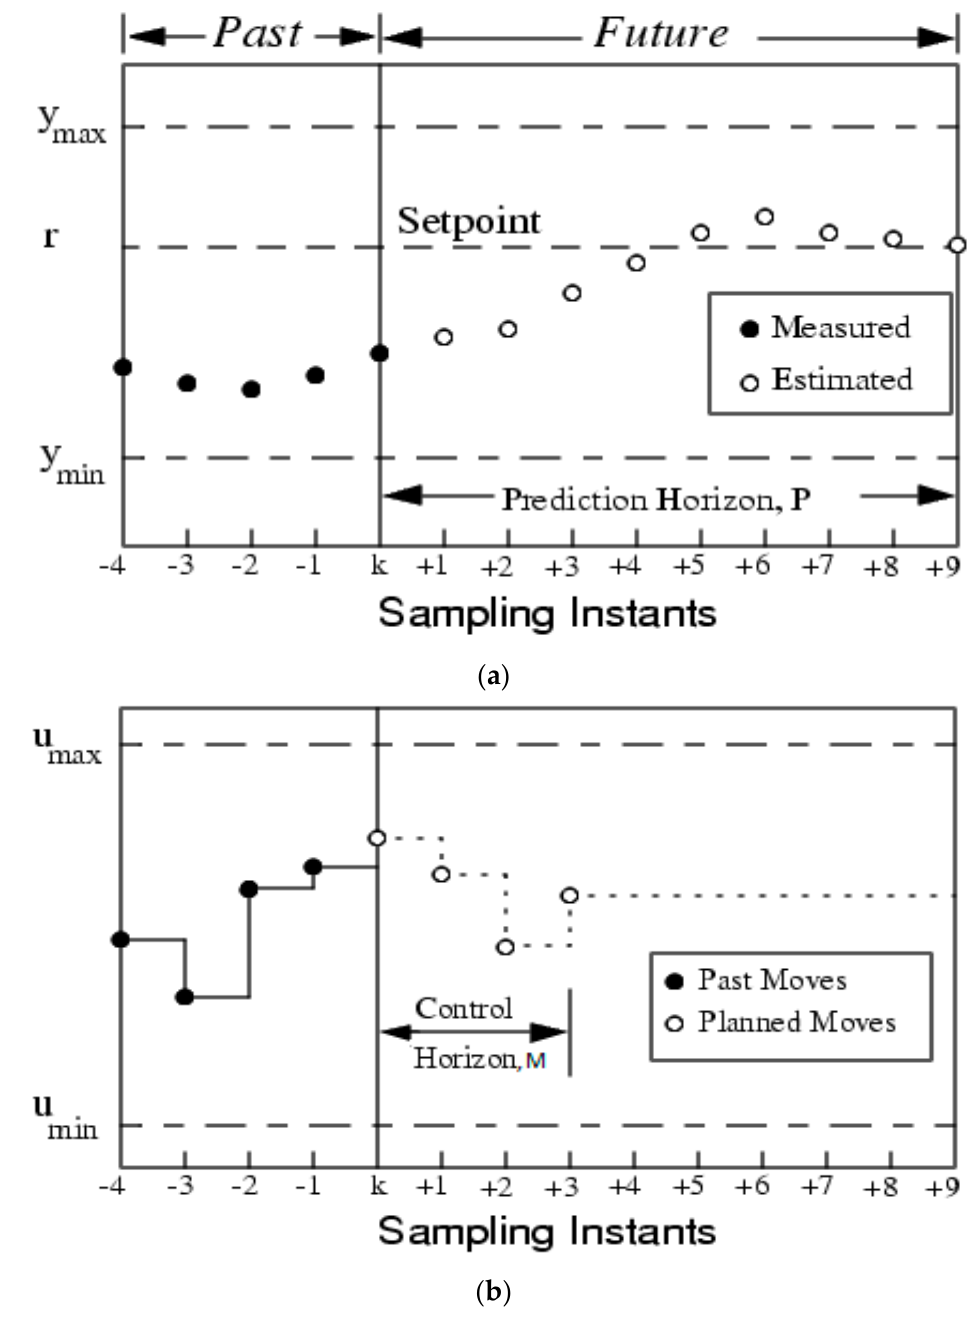
Figure 3. The MPC prediction process ( a ) predicted output, ( b ) control moves.